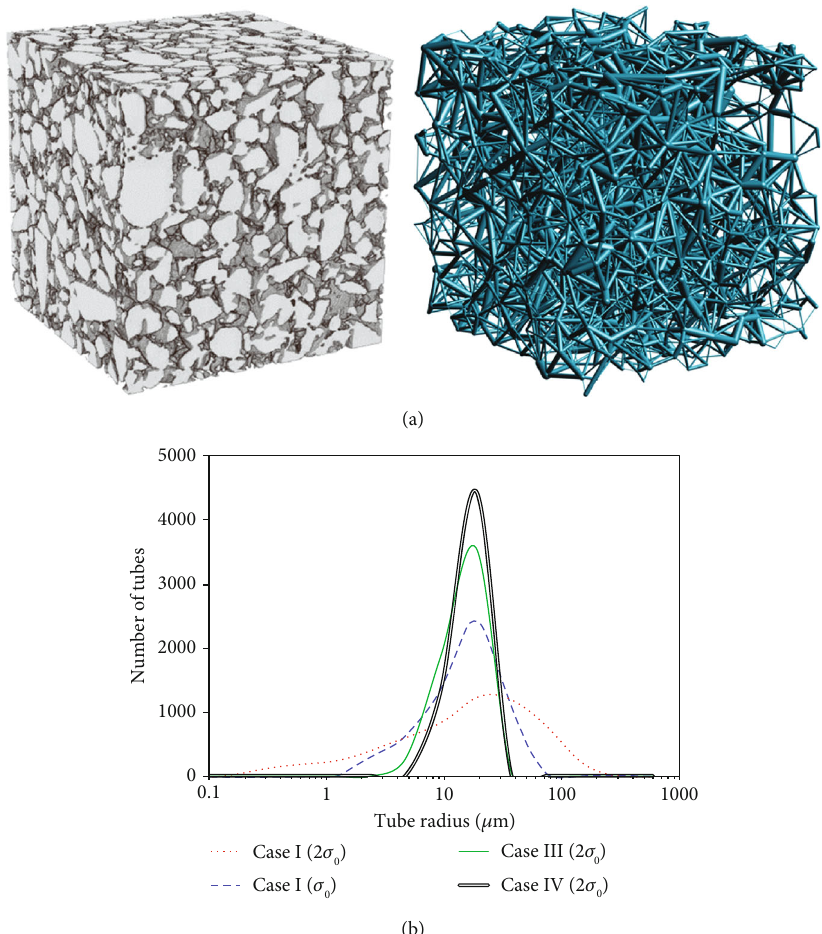
Figure 2: Tube network model extraction and modi fi cation. (a) X-ray CT image of a specimen (left) and the extracted tube network model (right). The dimensions of the network model were 2 mm × 2 mm × 2mm , and the model comprised 5775 tubes with a coordination number of cn = 8 : 0 . (b) Four tube size distributions used to modify the extracted tube network model. Three additional tube size distributions with di ff erent standard deviations ( σ = 0 : 1 σ , 0 : 5 σ , and 2 σ ) were generated. The average tube size was kept constant, along with the tube-size 0 0 0 rank order of the individual